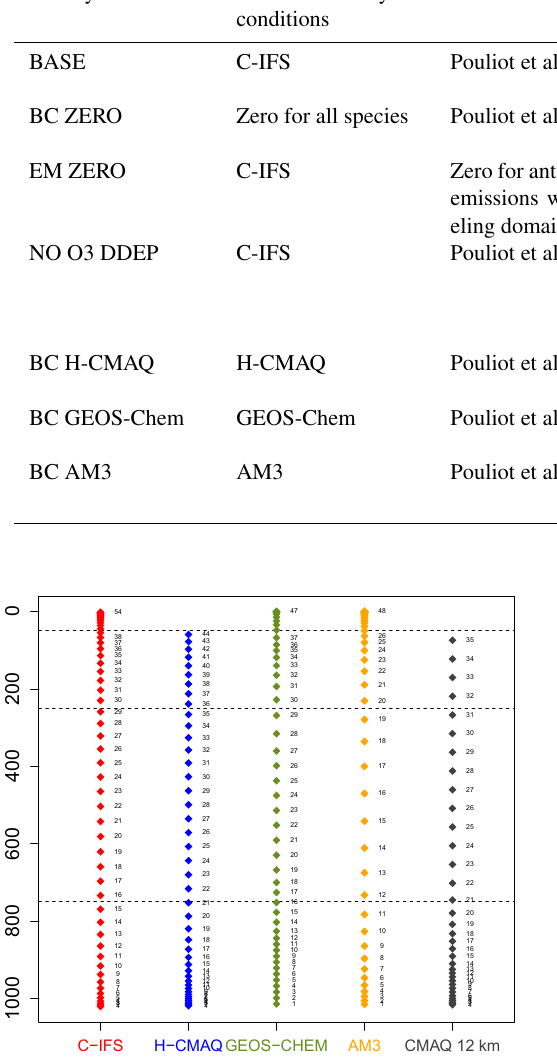
Figure 1. Depiction of the vertical levels used in the four differ- ent large-scale models and the regional CMAQ model analyzed in this study. The pressure values were extracted for a location near the southwestern corner of the 12km CMAQ modeling domain and represent annual average values for 2010 at the midpoint of each vertical level. The dashed lines delineate the three pressure ranges (surface to 750, 750–250, and 250–50mb) used for vertical integra- tion in subsequent